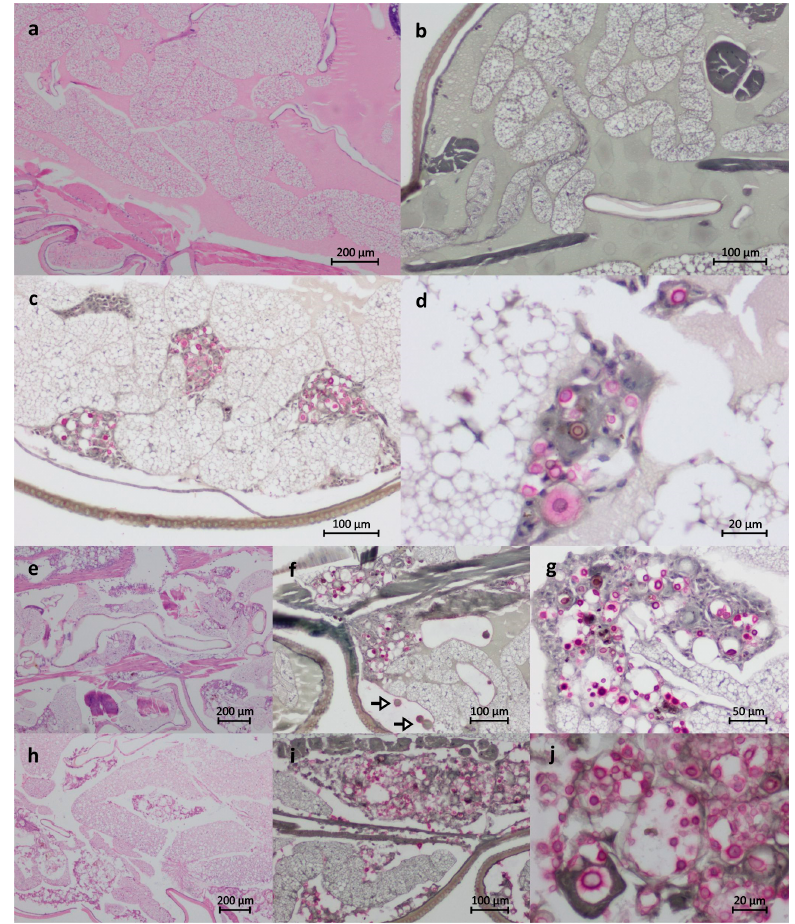
Figure 5. Hematoxylin and eosin (HE) and Mayer’s Mucicarmine (MM) stained sections of Galleria mellonella . Uninfected control larvae stained with HE ( a ) and MM ( b ) are shown. MM stained larvae infected with the low-virulence Cryptococcus gattii strain, CDCR272, show cryptococcal cells contained within small nodular lesions surrounded by hemocytes ( c , d ). Little muscle damage apart from nodular regions is seen. HE ( e ) and MM ( f , g ) stained larvae infected with the high-virulence C. gattii strain, CDCR265, show skeletal muscle damage and large nodular lesions. Giant cryptococcal cells, which are too large to be engulfed by hemocytes, are indicated by arrows. HE ( h ) and MM ( i , j ) stained larvae infected with the strain DMST20767 show extensive skeletal muscle damage. Cryptococcal cells are found in nodular regions and diffused throughout the surrounding tissue and hemocoel.